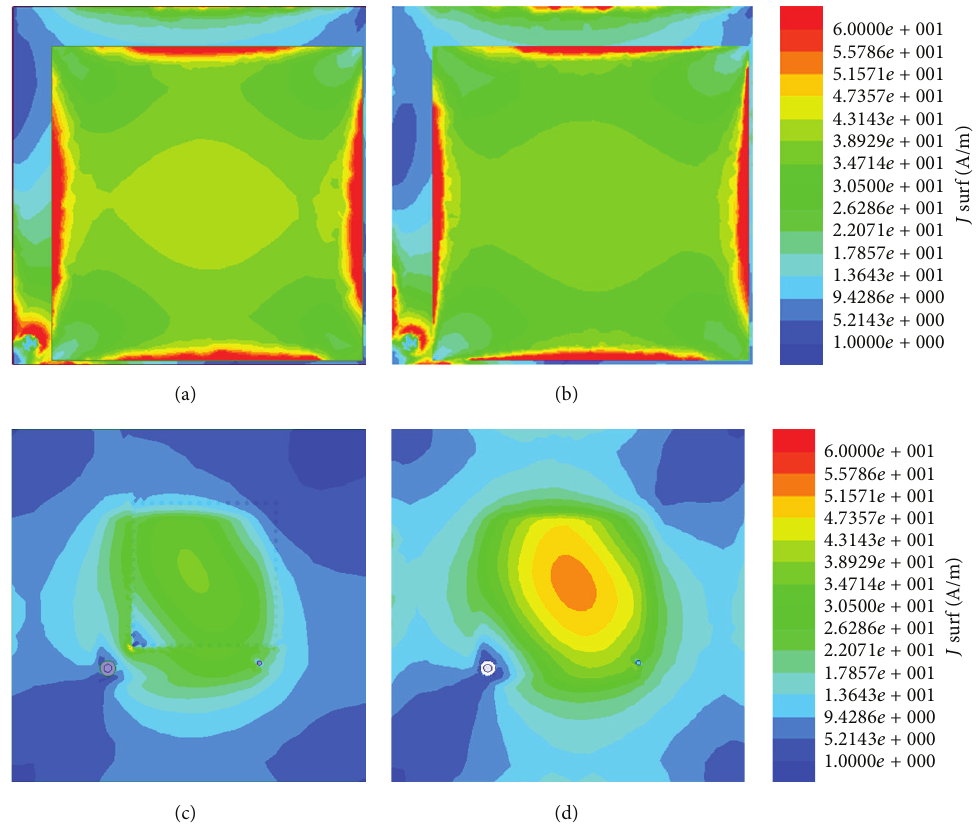
Figure10:Currentdistributioncharacteristics,(a)currentdistributiononthestacked-patchwithvias,(b)currentdistributiononthestacked- patch without vias, (c) current distribution on the ground with vias, and (d) current distribution on the ground without